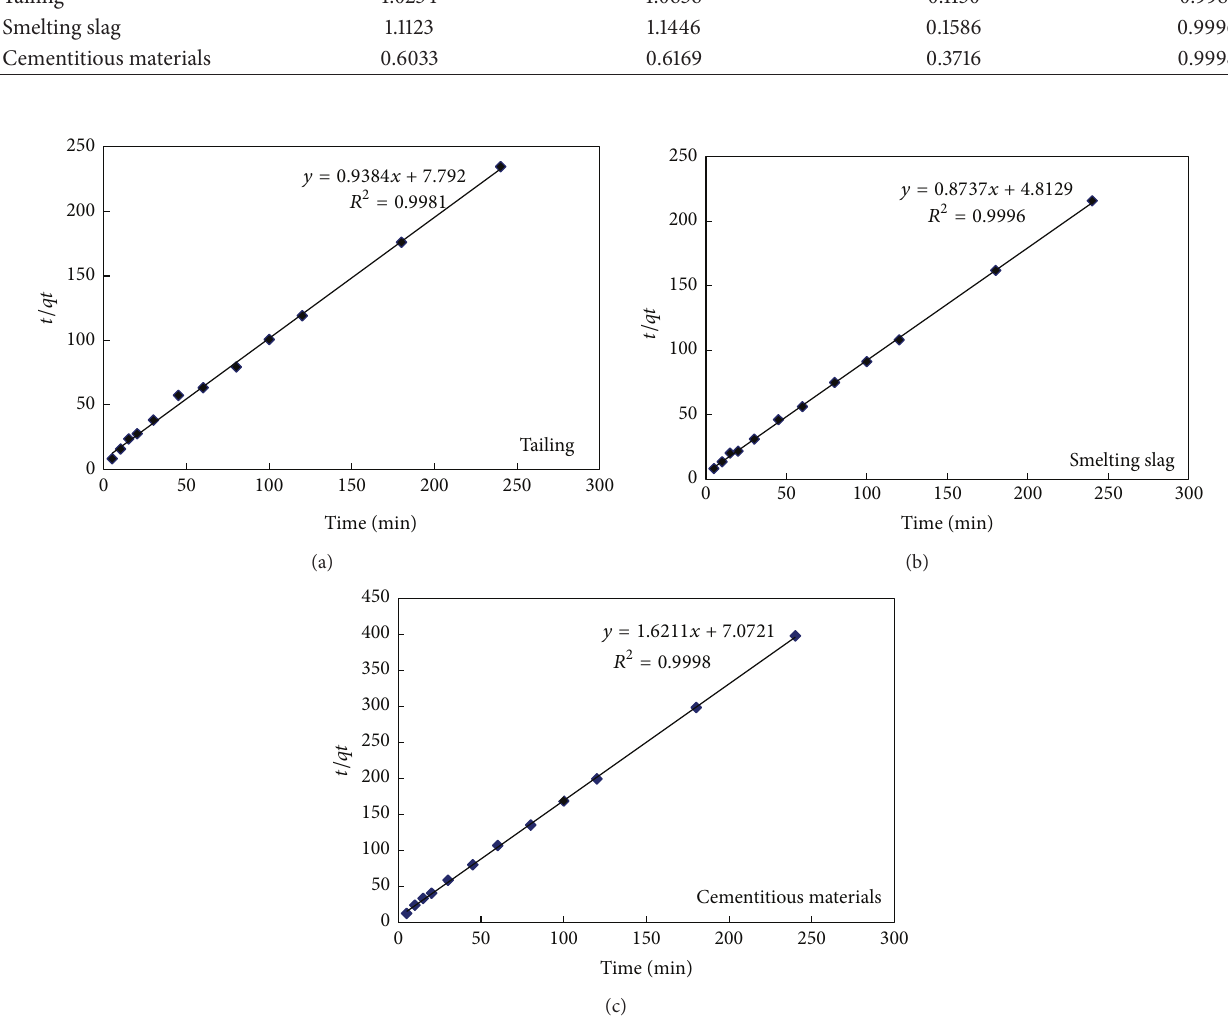
Figure 7: The quasi-two-level dynamic model of three